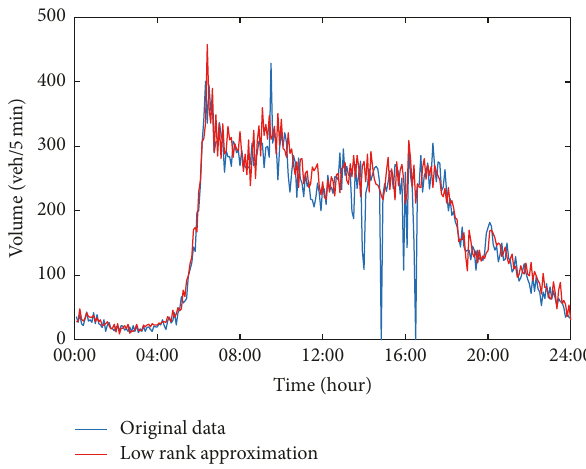
Figure 6: Low-rank approximation results of traffic